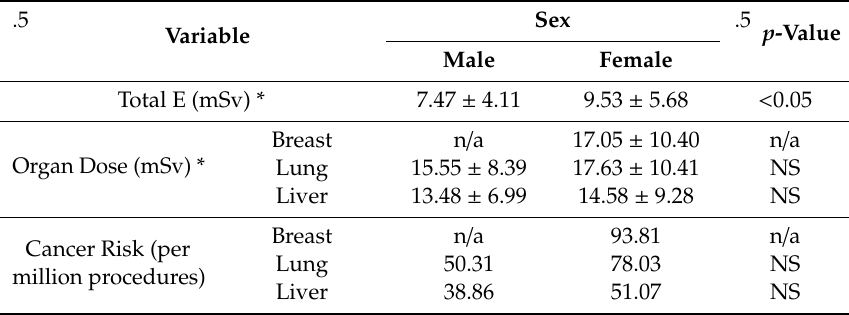
Table 5. Comparison based on different genders according to the CTPA examination.